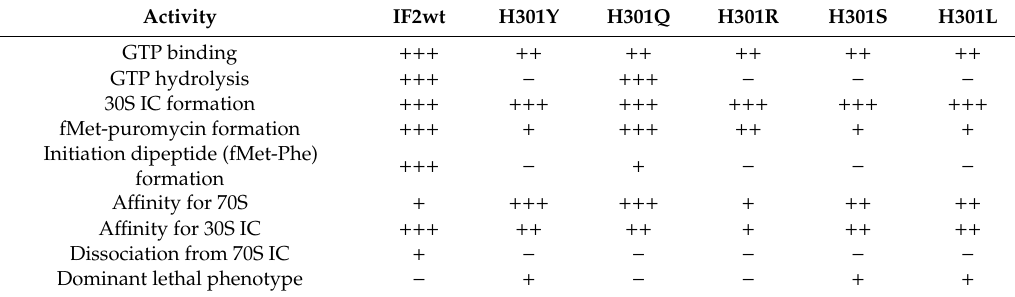
Table 2. Disparate phenotypes of IF2H301